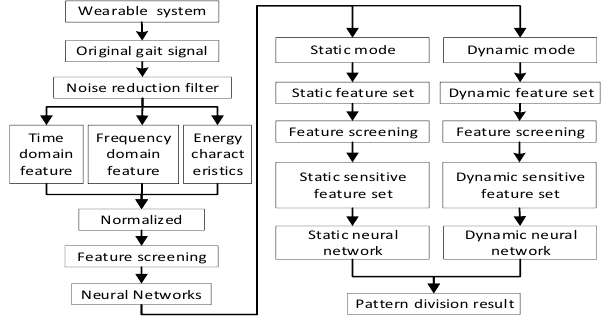
Figure 5. Motion pattern recognition model training process.